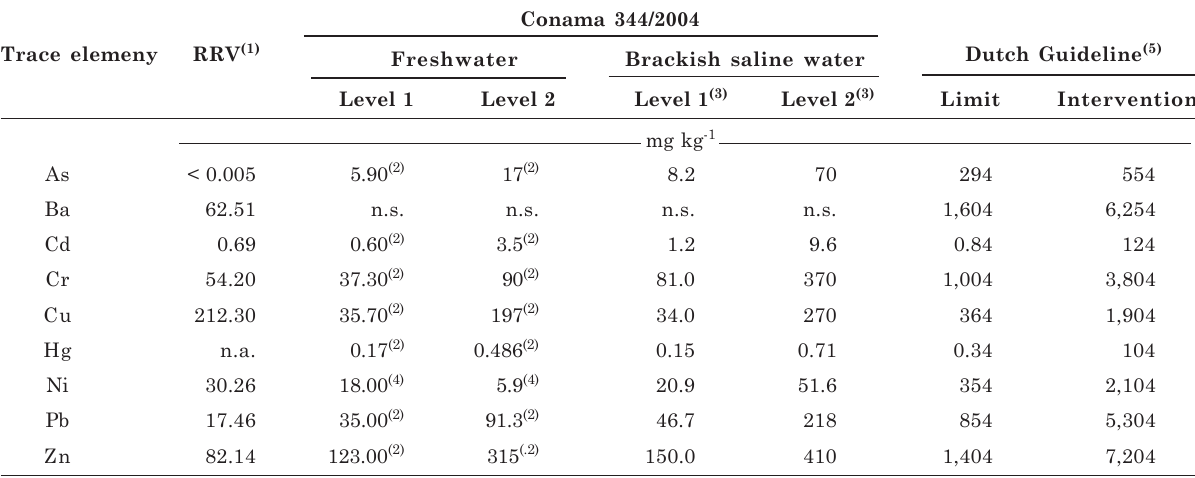
Table 6. Comparison of RRV to the maximum allowable trace element concentrations for disposal of dredged material established by Conama 344/2004 and limits and intervention concentration of the Dutch